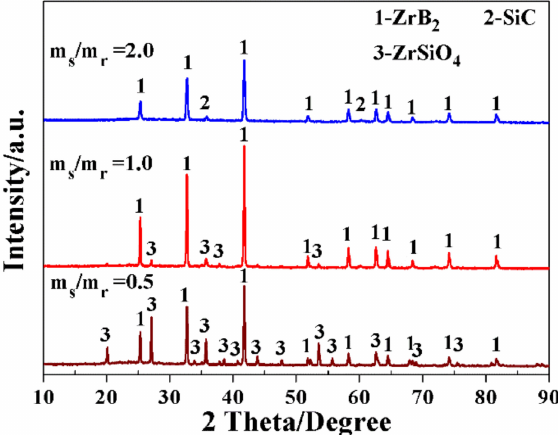
Figure 10. XRD patterns of the samples resulting from the MSM-BCTR method at 1200 ◦ C/20 min, with various salt/reactant weight ratios of 0.5, 1.0, and 2.0, respectively.